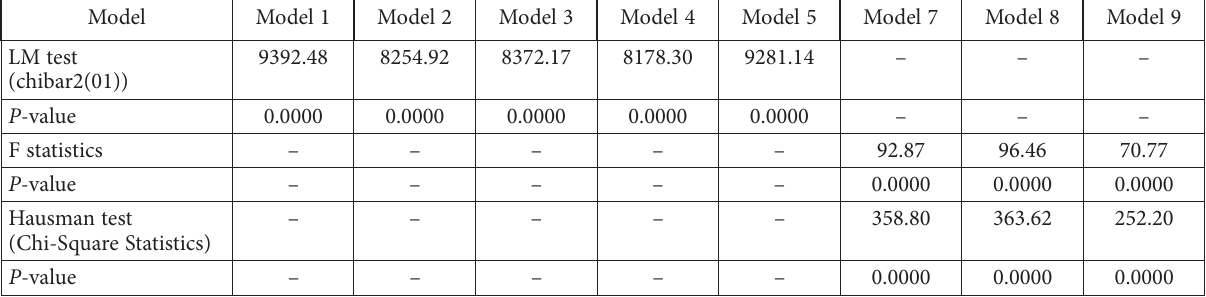
Table 1. The results of LM test, F test and Hausman